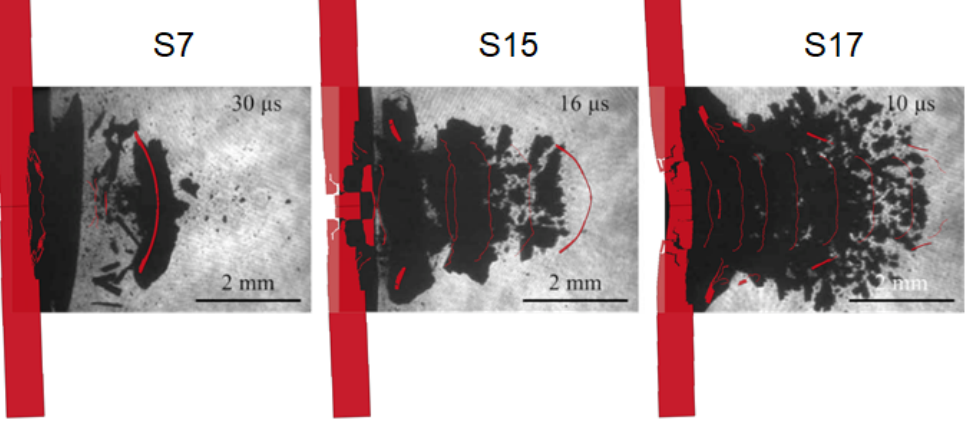
Figure 10. Representative shadowgraphies of shots S7, S15 and S17 (reprinted from [28]) and the respective numerical simulations.